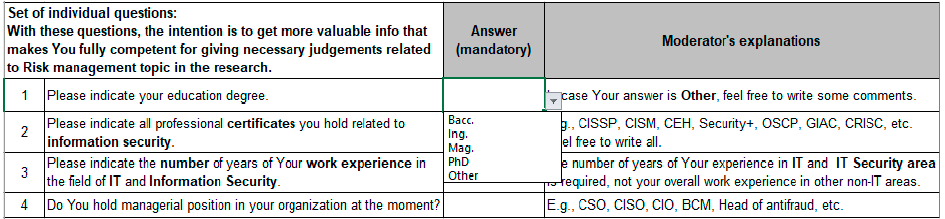
Figure A2. Set of the individual questions for IT security experts necessary to obtain the level of competence of respondents in the domain of information security.